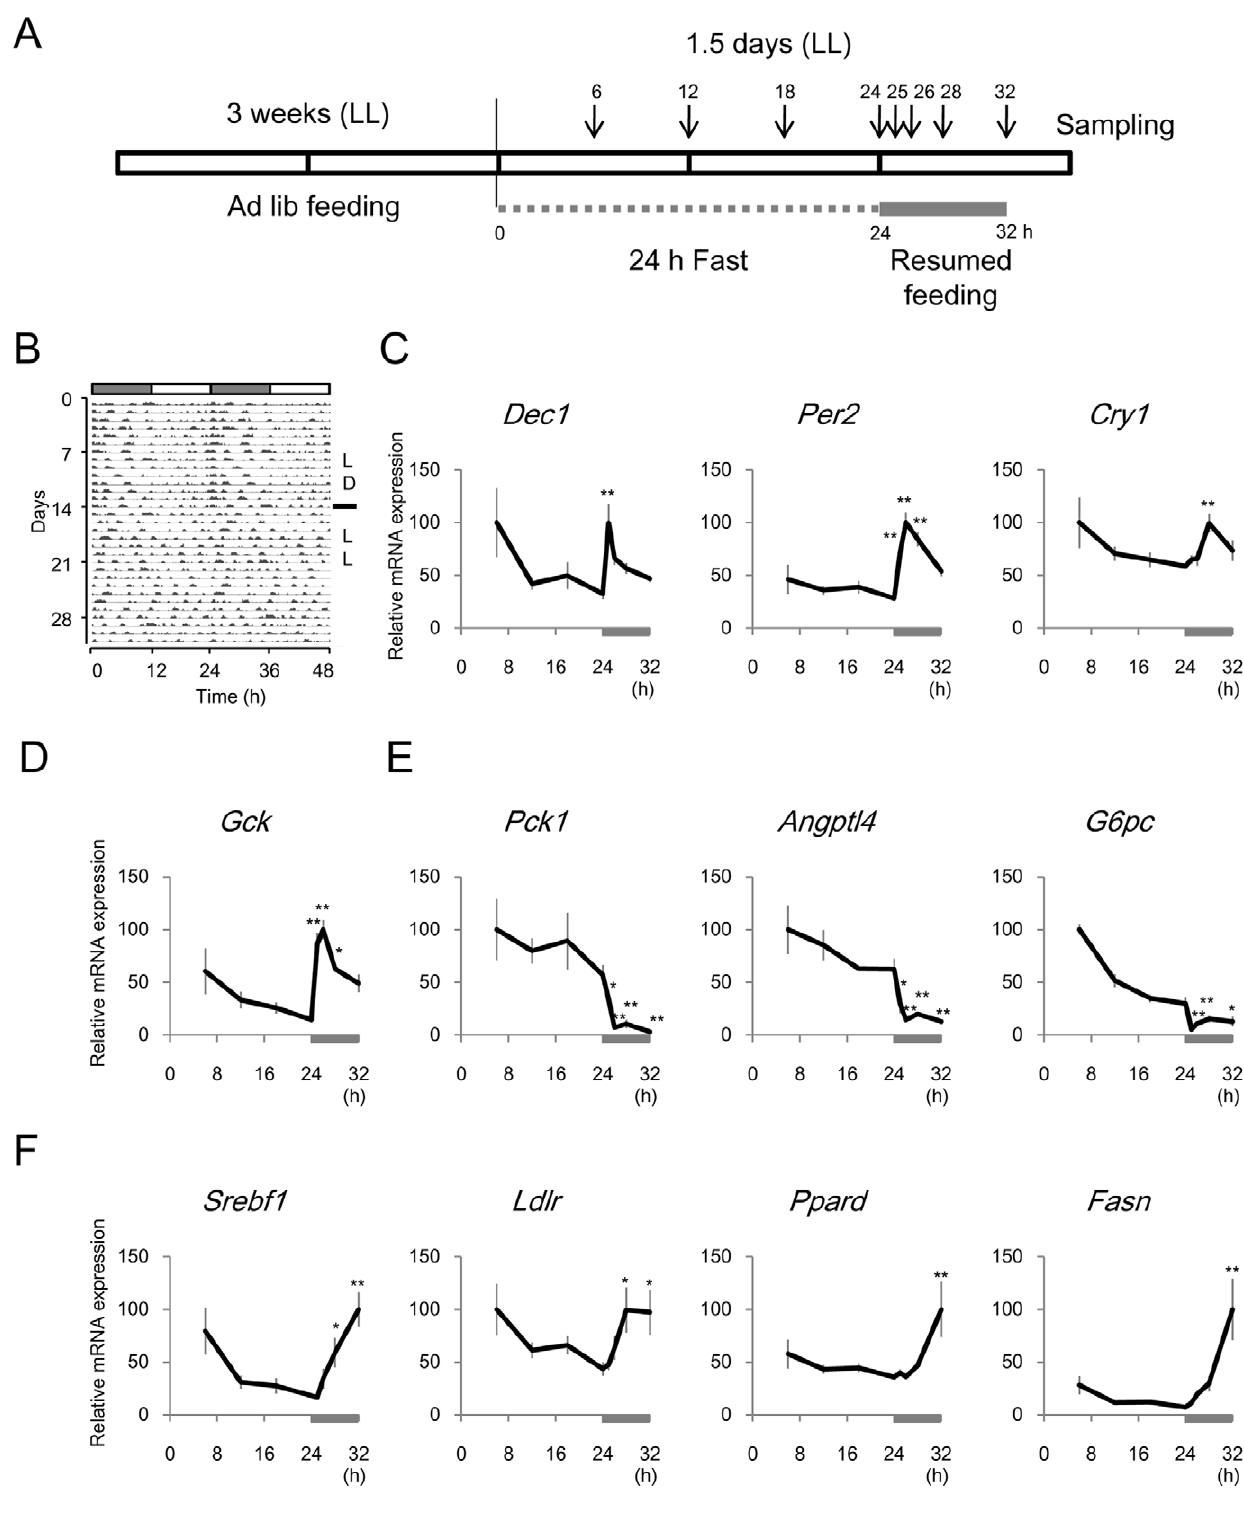
Figure 2. Rapid response of gene expression after resumed feeding in liver of Clock mutant mice. (A) Experimental design. Clock mutant mice were bred under constant light (LL) for 3 weeks, fasted for 24 h and then fed for 8 h. (B) Representative actogram from mice under 12-h light- dark (LD) cycle for 2 weeks that were switched to LL. (C–F) Expression profiles of mRNAs for clock genes (C), genes related to glucose metabolism (D– E), and fatty acid synthesis (F). Gray bars in both panels, duration of resumed feeding. Data are shown as means 6 SEM (n=5 for 25 h, n=4 for 12, 18, 24 and 26 h, and n=3 for 6, 28, and 32 h; * p , 0.05, ** p , 0.01; 24 h vs. 25–32 h; Dunnett’s test).